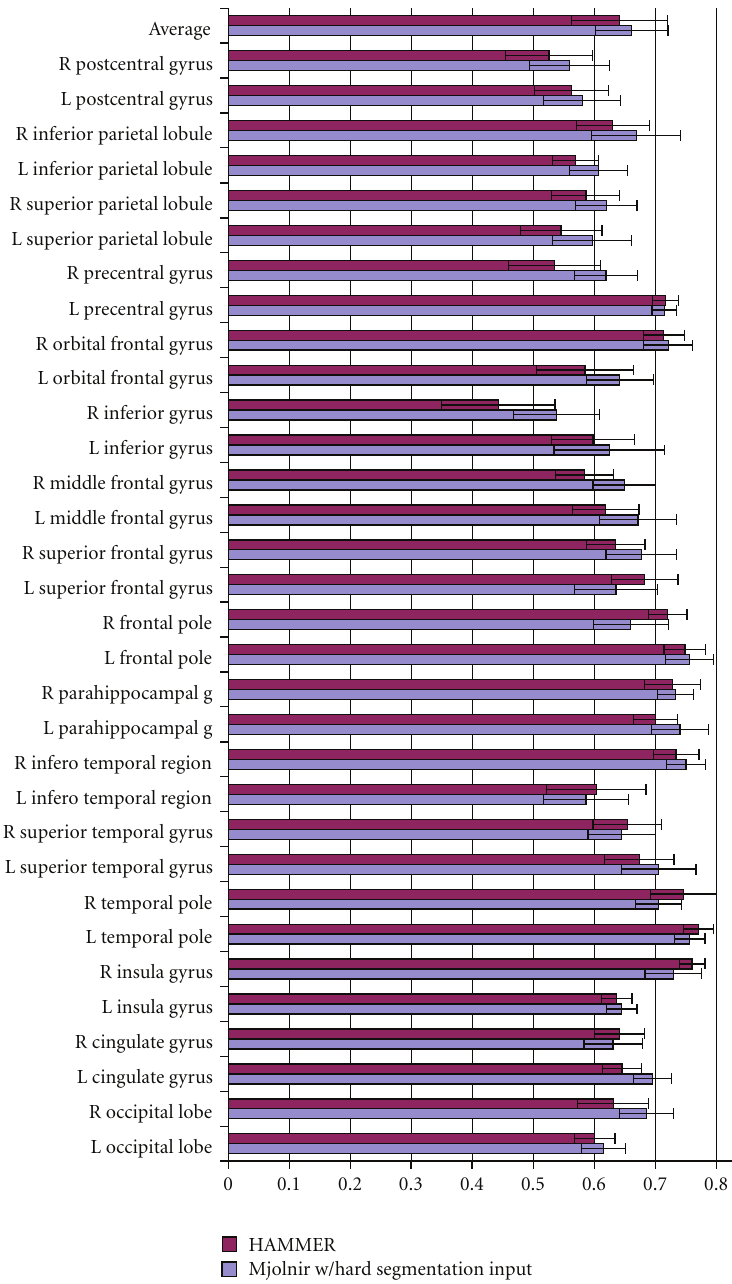
Figure 9: Demonstration of the benefits of Mjolnir’s displacement field interpolation. The input to both algorithms (HAMMER and Mjolnir) was the hard segmentation of the image; hence the attribute vectors in both methods are the same. The top row shows the average over all regions, and the error bars represent the standard